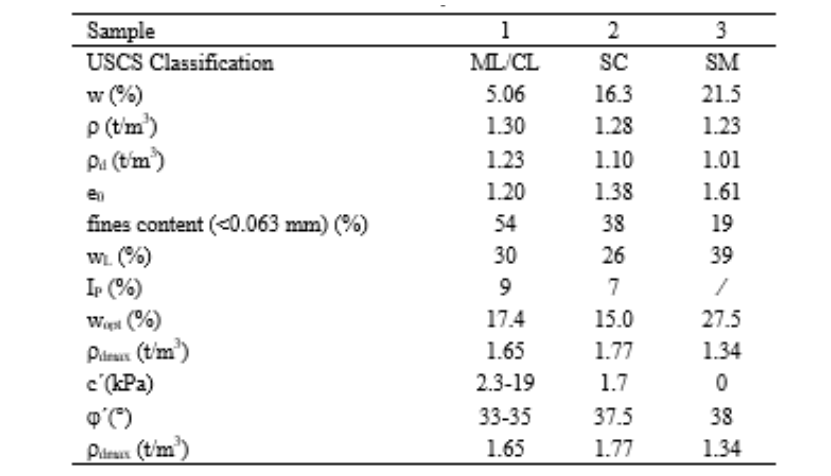
Table 2. Properties of three typical groups of soils from the top